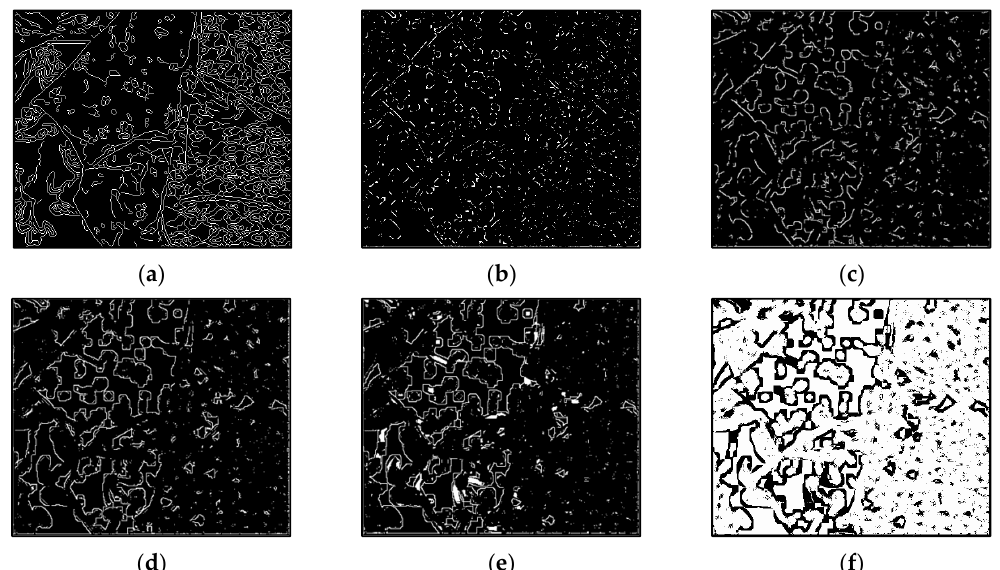
Figure 12. The results of Cloth2 by AWCT. ( a ) Edge information and schematic diagrams of the biggest window size in ( b ) 13 × 13, ( c ) 15 × 15, ( d ) 17 × 17, ( e ) 19 × 19, and ( f ) 21 × 21.